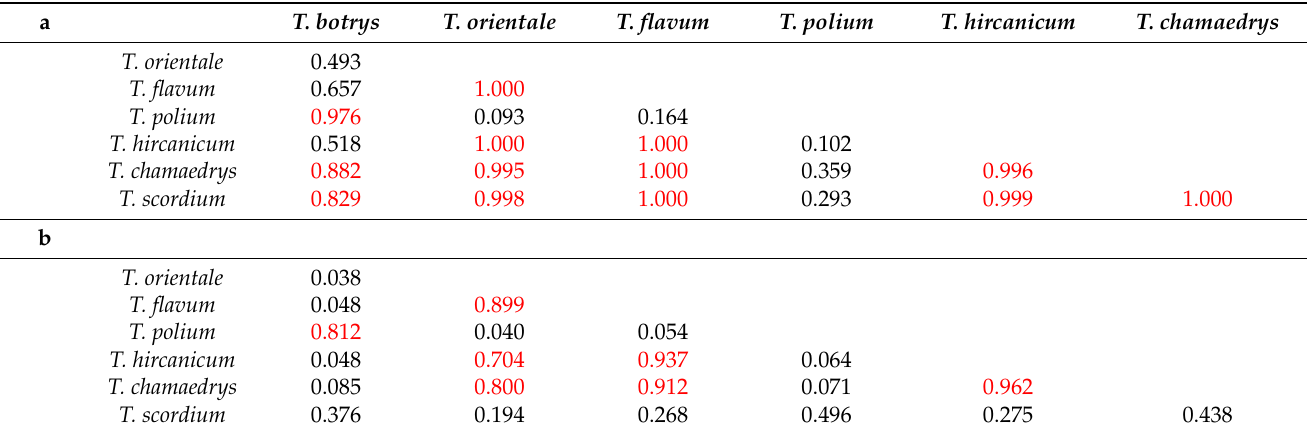
Table 4. The pairwise ANOVA parametric Tukey’s Q test ( a ) and non-parametric Mann–Whitney U test ( b ) illustrating the probability that the means are equal ( a ) or the distributions are the same ( b ). The significant probabilities are presented with red